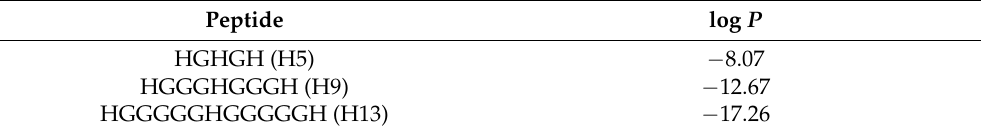
Table 2. Log P values of synthesized peptides calculated by Spartan’18 software.